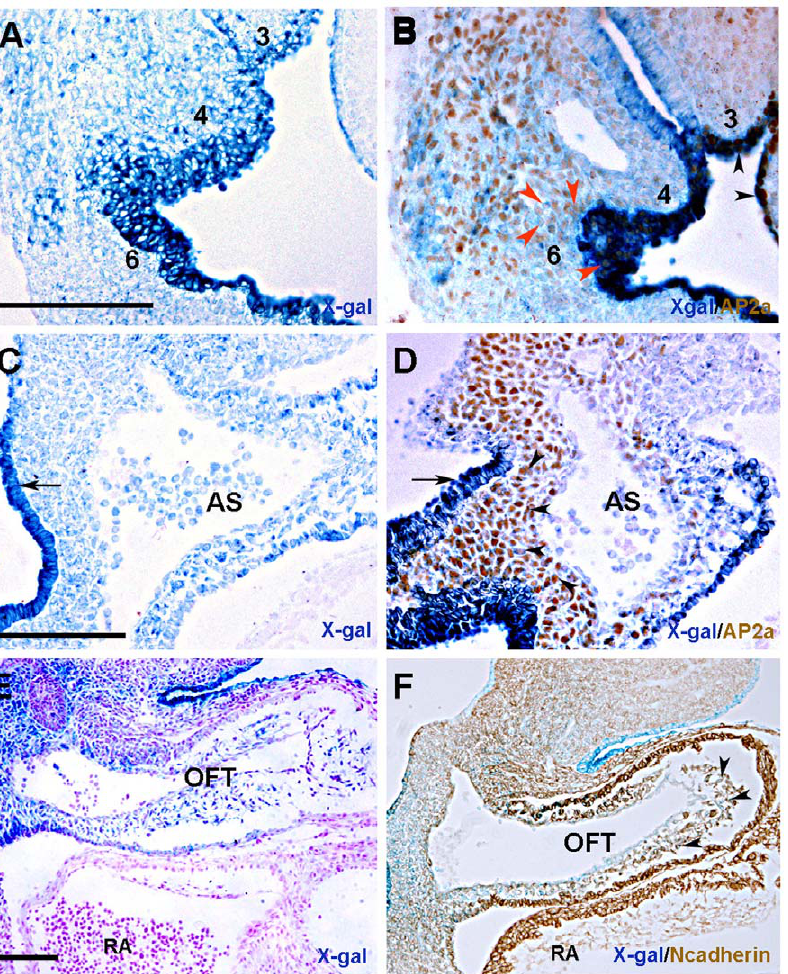
Figure 3. lacZ -positive cells in the pharyngeal arches, aortic sac and OFT identify migratory neural crest cells. Sagittal sections of E10.5 transgenic embryos at the level of the 3 rd , 4 th and 6 th pharyngeal arches (A, B), aortic sac (C, D), and outflow tract (E, F). Ap2 a (B, D) and N-cadherin (F) immunochemistry on X-gal-stained adjacent sections demonstrates that lacZ -positive cells in the pharyngeal arches (B) as well as those populating the space between the pharyngeal endoderm and aortic sac (D) and outflow tract mesenchyme (F) are cardiac neural crest cells. Arrowheads and arrows (B) indicate the pharyngeal ectoderm and AP2 + LacZ + cells in pharyngeal arches ectoderm and mesoderm, respectively. Arrows and arrowheads (C, D) show the pharyngeal endoderm and AP2 + LacZ + cells, respectively. AS, aortic sac; OFT, outflow tract. RA, right atrium 3, 4, and 6 indicate the 3 rd , 4 th and 6 th pharyngeal arches, respectively. Scale bars=100 m m.